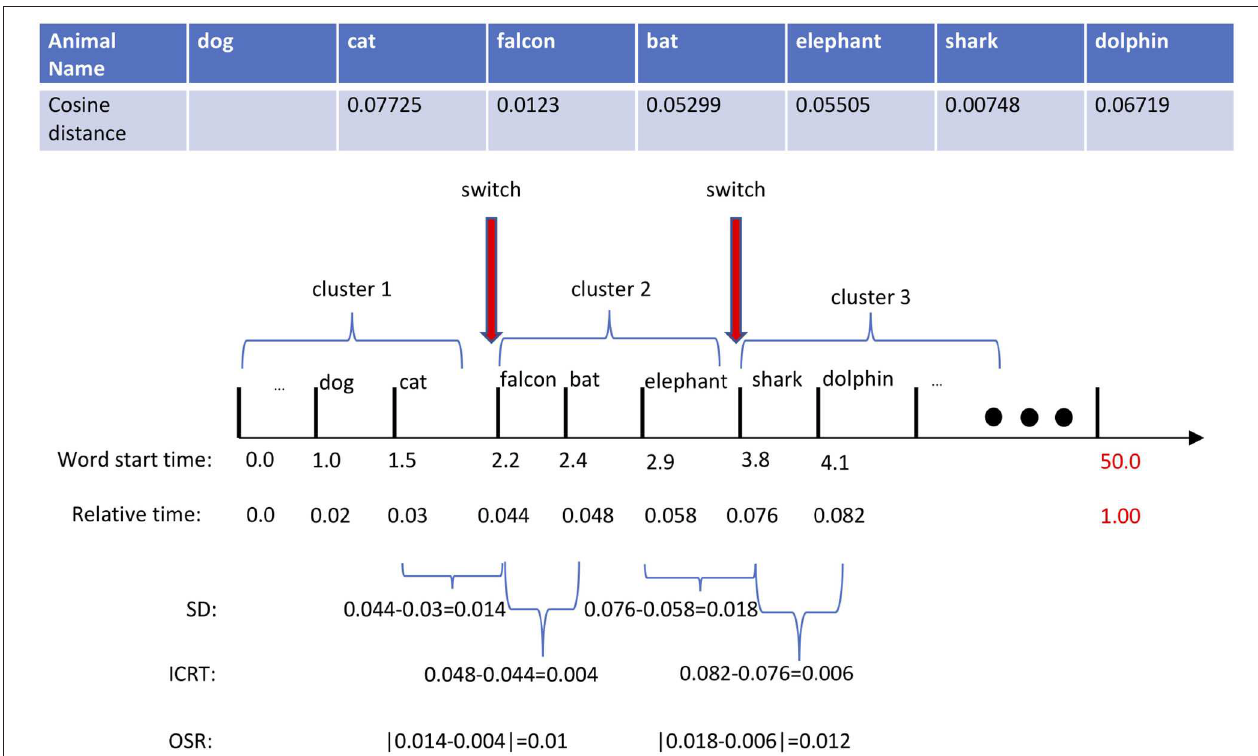
FIGURE 1 | In this example, we manually set the threshold to 0.05. Based on that, there exists two switching positions marked by red arrows. The switching duration (SD) of the first switching is 0.7 | the time difference between falcon and cat. The intra-cluster retrieval time (ICRT) of the first switching is 0.2 | time difference between bat and falcon. Thus, the absolute difference between the SD and ICRT in the first switch, optimal switching rate (OSR) , will be